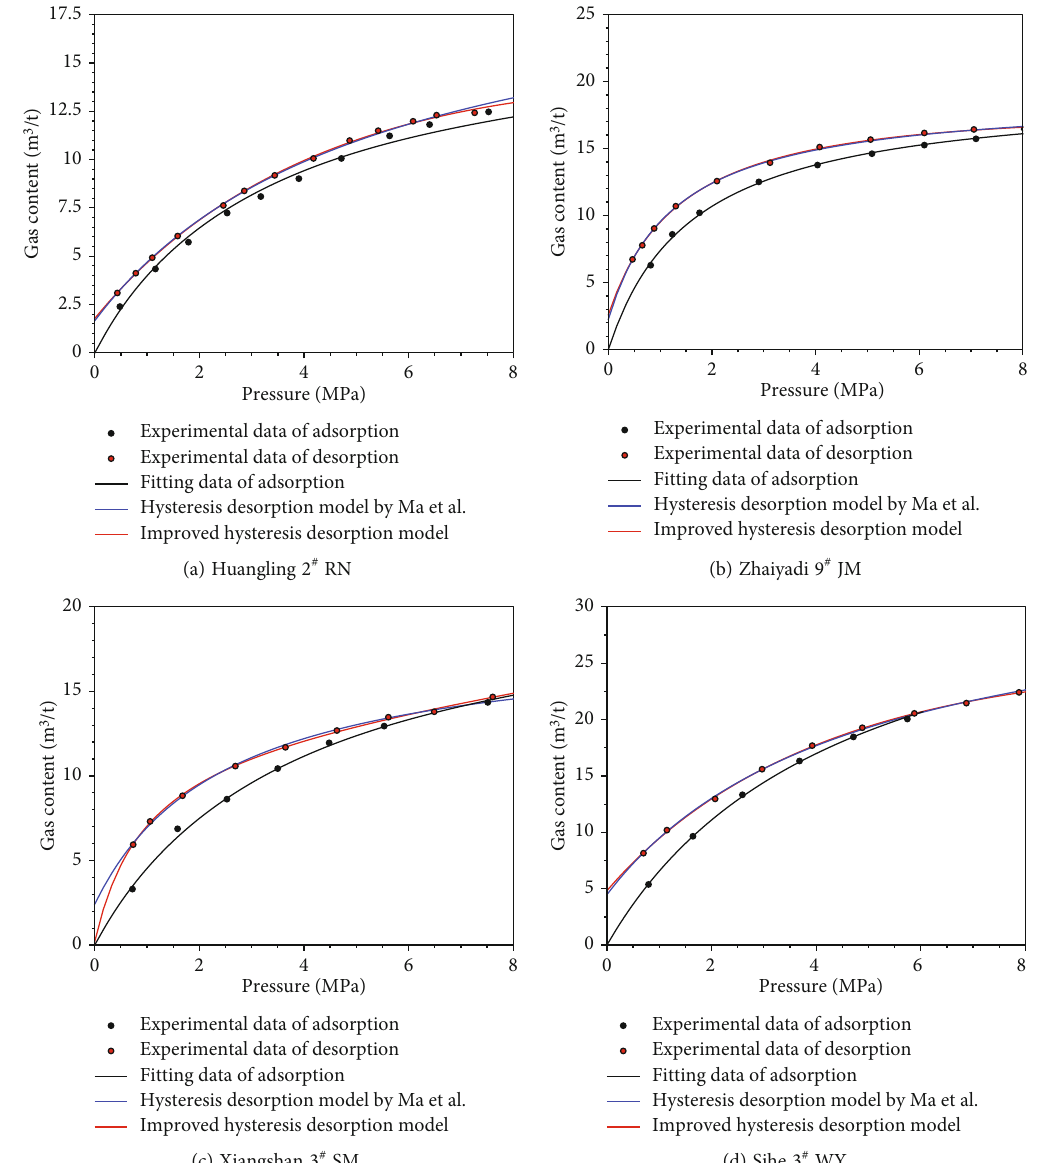
Figure 3: Experimental data and improved fi tting curves of four di ff erent coal